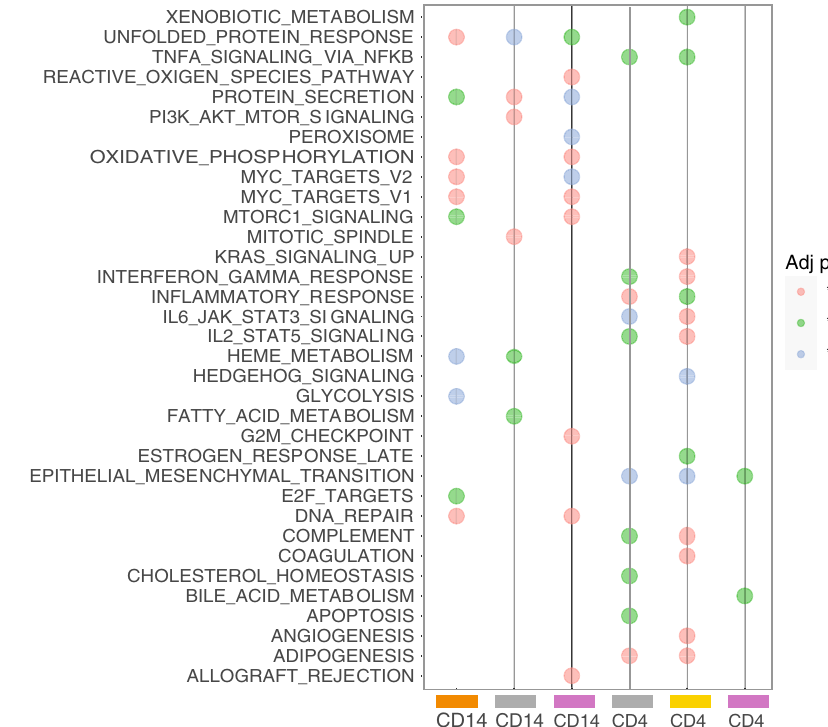
Fig. 4 Gene co-expression analyses. A Group fold change heat map and hierarchical clustering for the four data-driven sample groups and the gene modules identi fi ed byCoCena2 analysis. Classi fi cation: the annotation of the modules into different categories based on their behavior. B Functional enrichment of CoCena2-derived modules classi fi ed as “ Opposite behavior according to ethnicity using the Hallmark gene set database ” . Only signi fi cant terms are